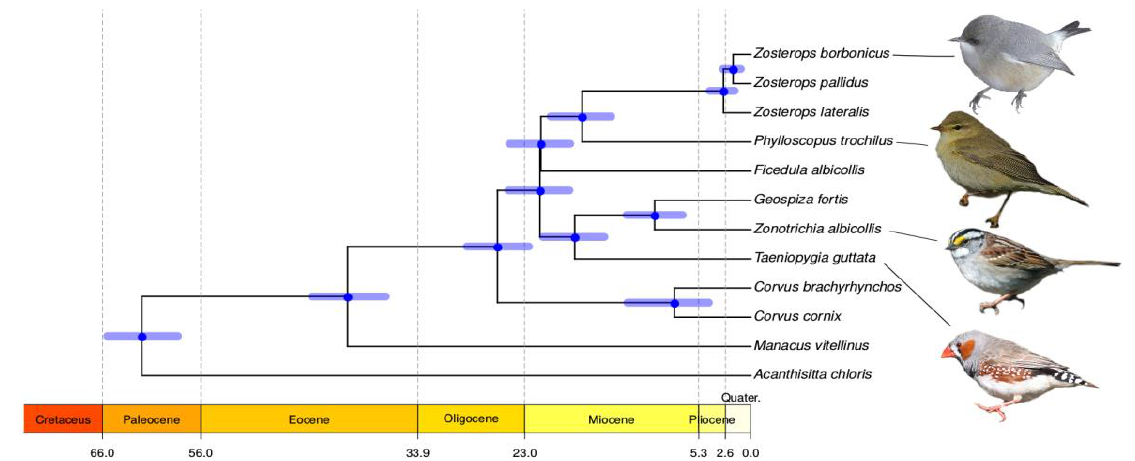
Figure 3. Molecular phylogeny and dating of the investigated passerine birds. Estimates of molecular dating are based on dataset 1 and calibration set 1 (Table S3). For greater clarity, the cladogram focuses on passerine birds only, but see Fig S3 for a cladogram of the inferred phylogeny for the whole set of investigated avian